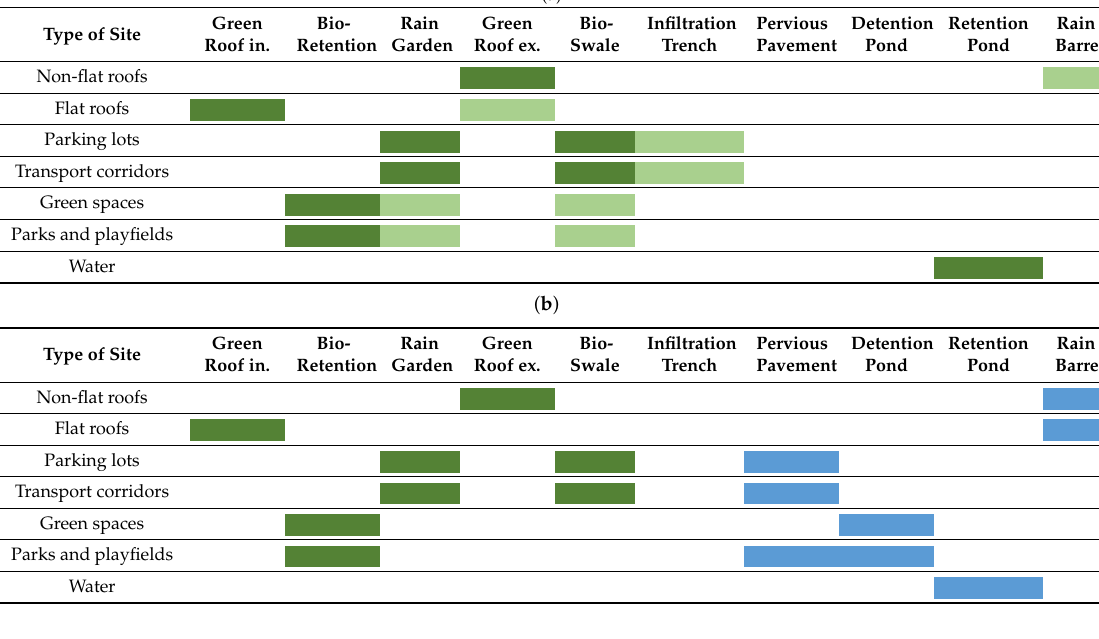
Table 5. ( a ) Preferred measures according to co-benefits for each land-use category (preferred: dark green; second preferred: medium green); ( b ) preferred measures according to co-benefits (preferred: dark green; second preferred: medium green) and flood risk reduction (preferred: blue) for each land use category.